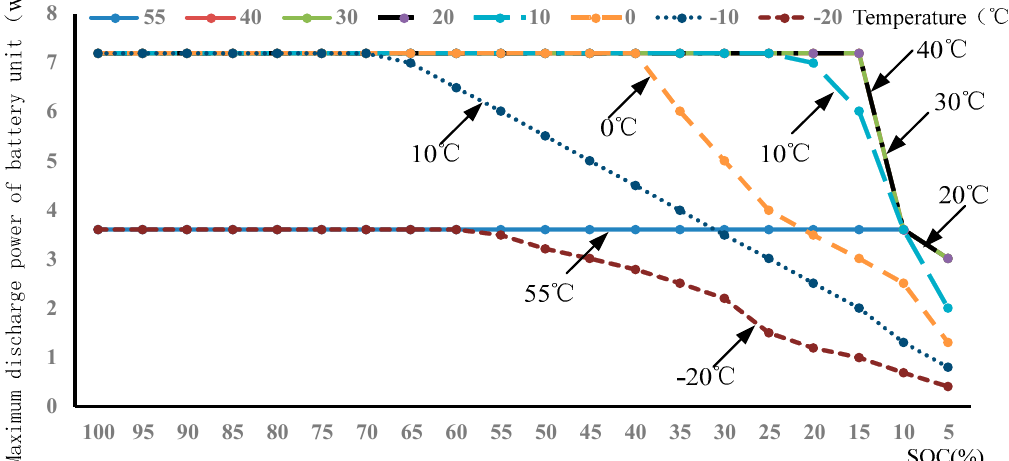
Figure 3. Maximum discharge power of the battery unit with SOC at different ambient temperatures.